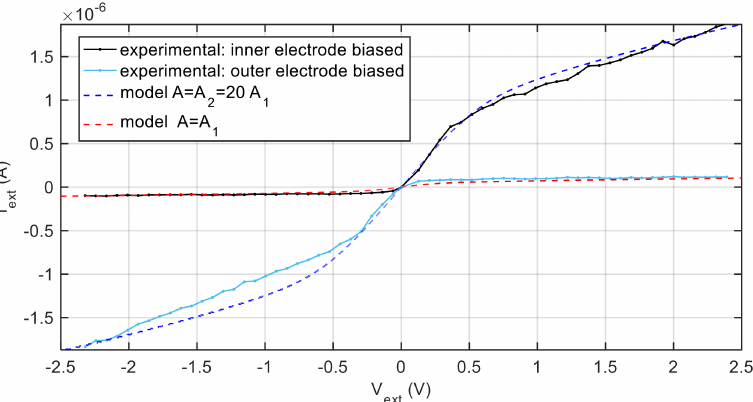
Figure 9. I-V characteristics obtained with the automotive spark plug driving the inner electrode (black solid line with markers), and the outer electrode (cyan solid line with markers). Blue and red dashed lines: model predictions obtained considering two symmetrical sensors, as per legend.